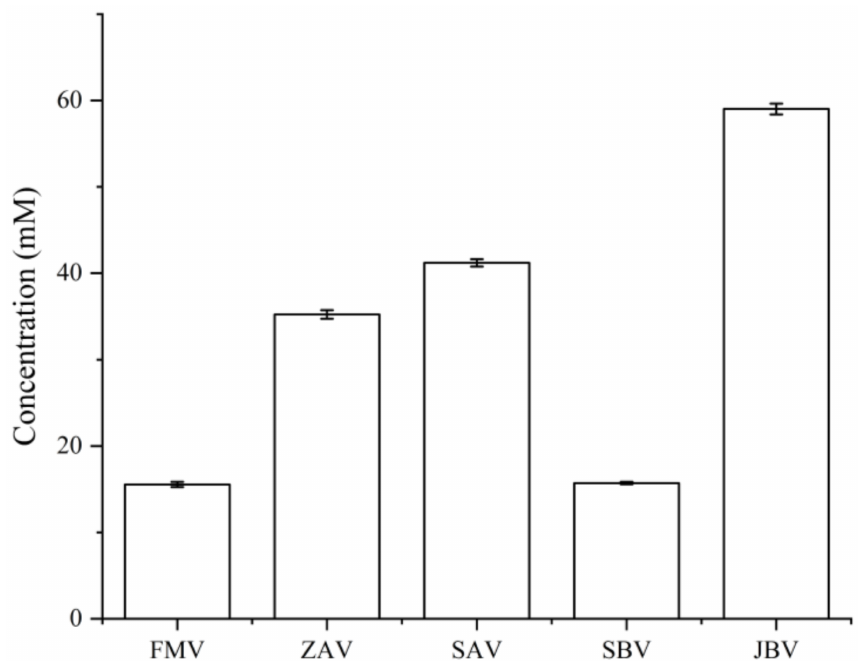
Figure 4. Total concentration of labeled metabolites measured by LC-UV in different vinegars. The concentration data with an error bar are presented as the mean ± SD of three replicates ( n =